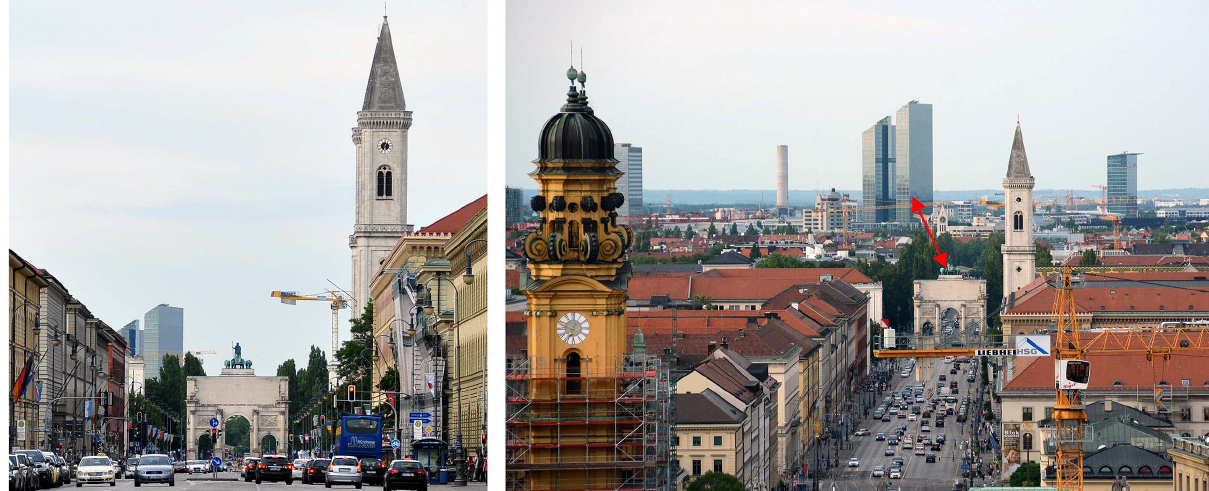
Figure 1. Axial view of Ludwigstrasse in Munich with Victory Gate at its end and a tall building above it. The distance between the building and the gate is about 3.0 km (marked with arrow)